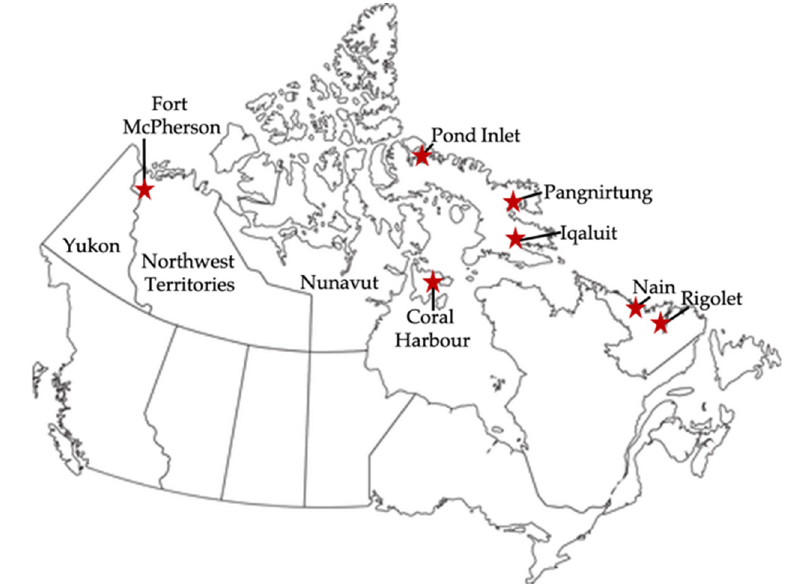
Figure 1. Map of Canada highlighting key locations discussed in this review (map outline from Creative Commons).